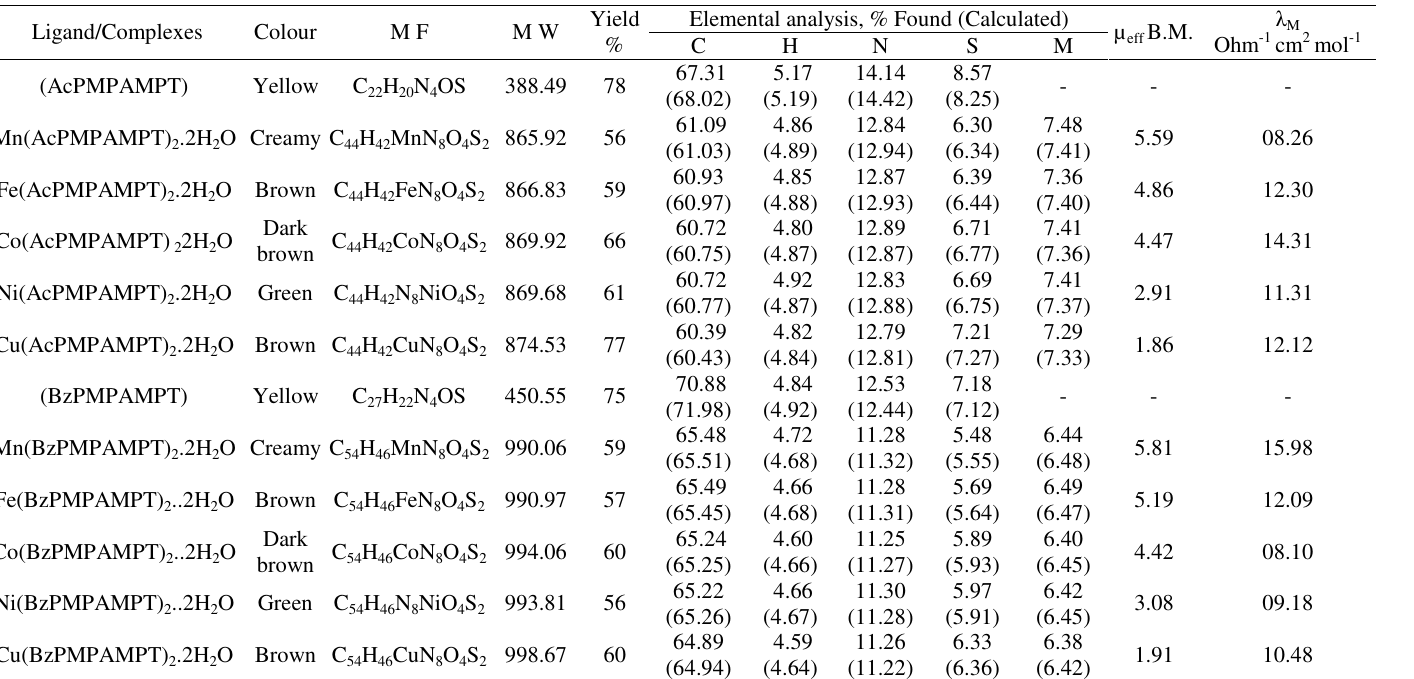
Table 1. Analytical and physical data of Schiff base ligands and complexes